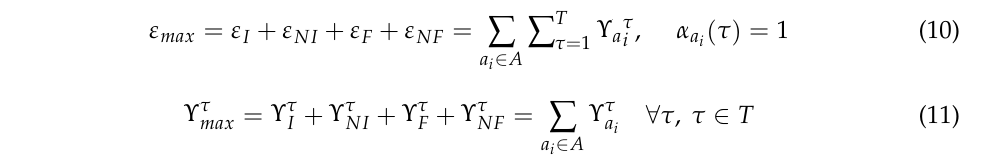
10 of 21 Figure 3. Activities to design the User Interface of the demand home energy management system with IoT. The question goes a little bit further when defining the interaction technique, as a selection might be influenced by social computing or gamified strategies. To address the gamification aspect, the Octalysis Framework [46] provides a complete guide on how to effectively consider some strategies. In the context of the demand home energy manage- ment system, this is a challenge as the human behavior, we hope, might change thanks to the awareness of electricity consumption. Finally, the codesign Framework focuses on Social Computing to achieve a perfect balance between social behavior and computational systems, and it seeks to create new practices that allow socialization through technology. The demand home management system includes certain actions that family members or acquaintances, in the case of shared floors, can perform, since the application will be used by any member of a com- munity using the same devices. For instance, to share a limit of energy expenditure, an alert will be sent to each of the participants warning them of their current consumption with the aim of thm knowing a little more about the depth of their electrical activity, and this can be complemented with smart connection devices to the current in which, through Siri or Alexa, you can identify the devices that consume more energy. In this way the different members can see the consumption of other participants and send messages warning of excessive consumption in some area of the house or even emojis, allowing interaction between participants of the same family. Plus, if the monthly goal of maximum energy consumption is achieved, it can be shared on social networks such as Facebook. This way of working, of co-design, allows the design of a solution close to the context of use, and that, in principle, is a good first step towards the